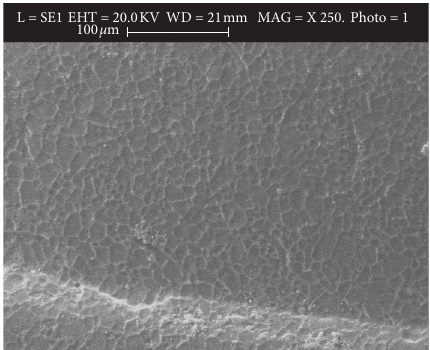
Figure 3: Electro-micrograph showing microporosities and micromechanical retention of adhesive remnants in DP